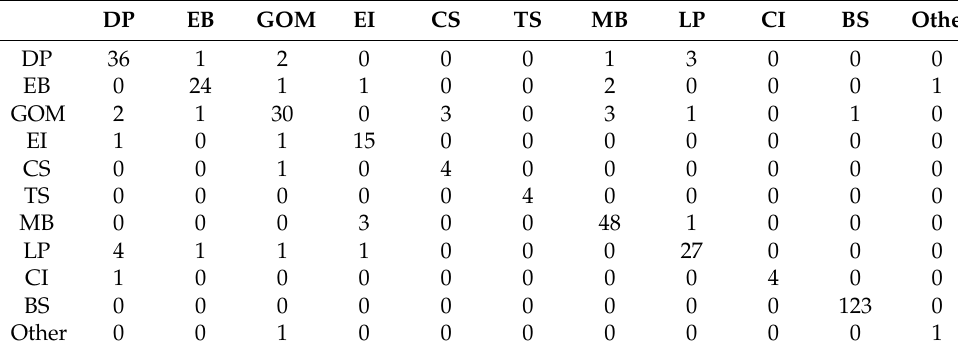
Table 6. Confusion matrix of classification for the test